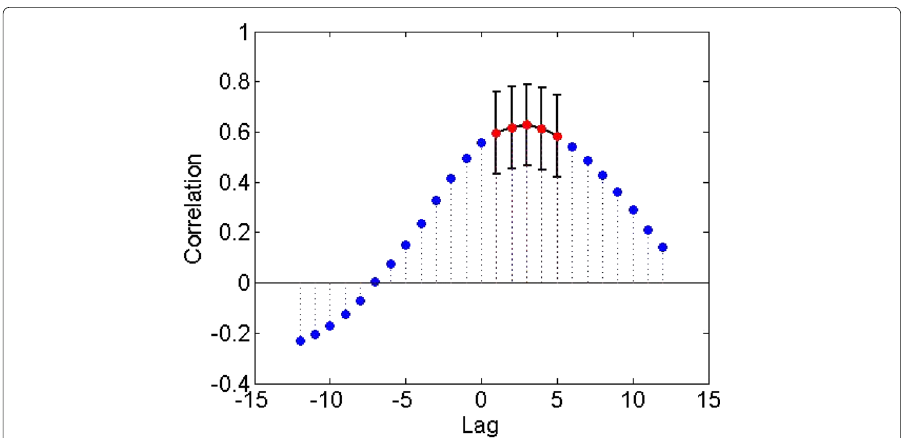
correlations for a false discovery rate q = 10 − 3 with red. The error bars correspond to ± one standard deviation, as estimated by Eq.